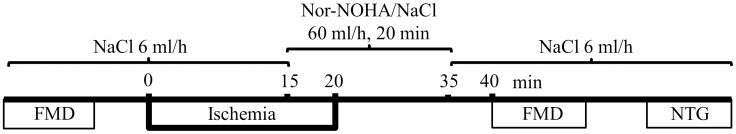
Study protocol.FMD, flow-mediated dilatation; NaCl, sodium chloride; Nor-NOHA, Nω-hydroxy-nor-arginine; NTG, nitroglycerine.